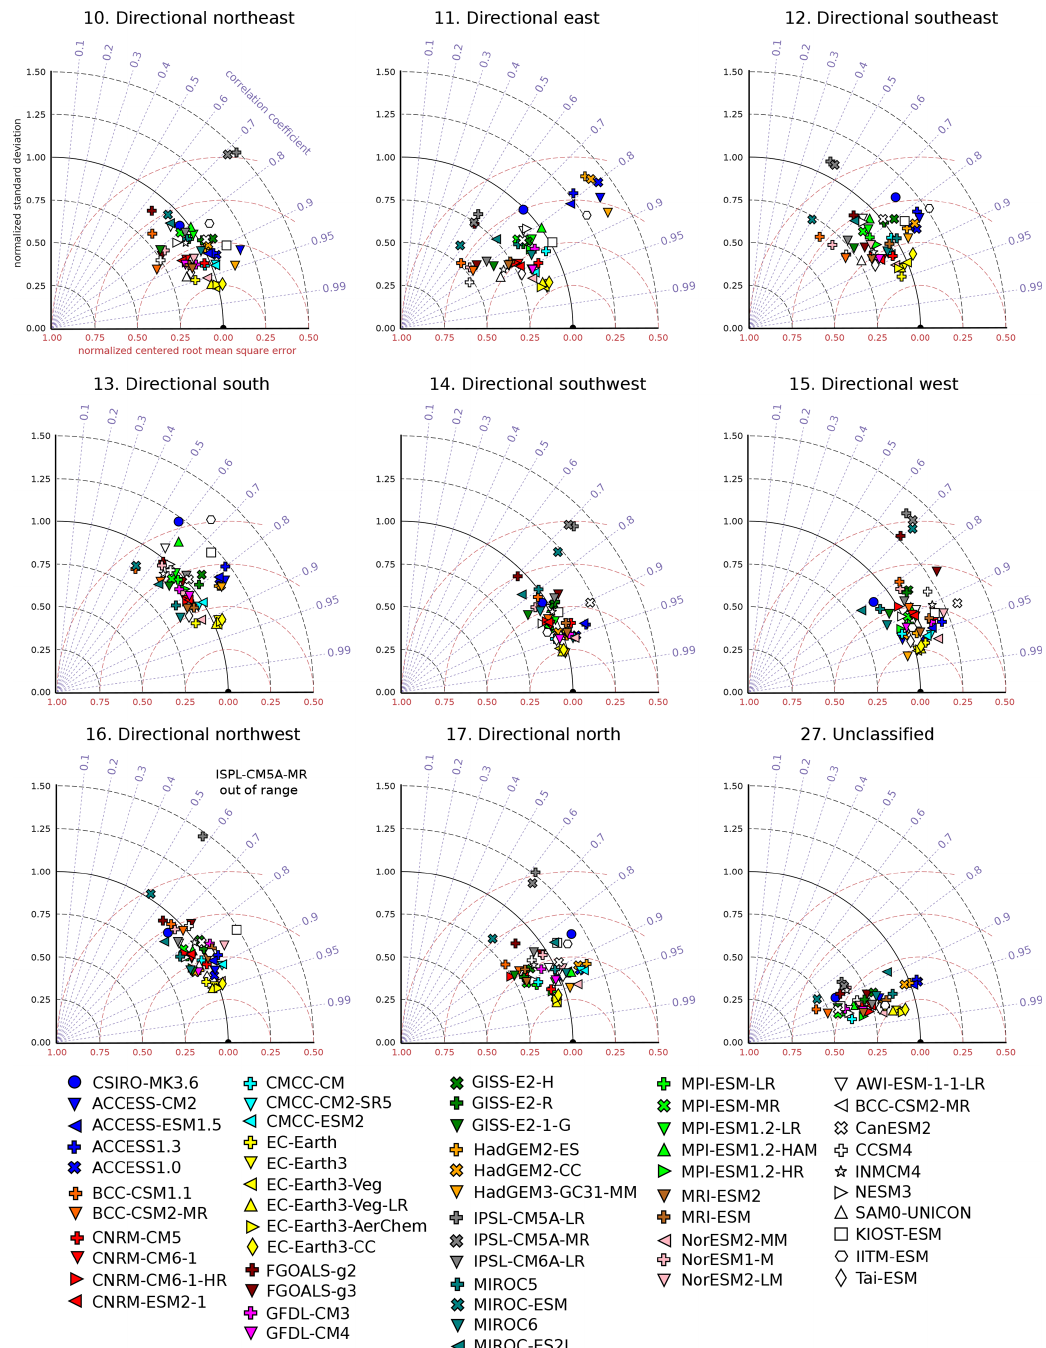
Figure 15. As Fig. 14 but for the eight purely directional Lamb weather types and the unclassified